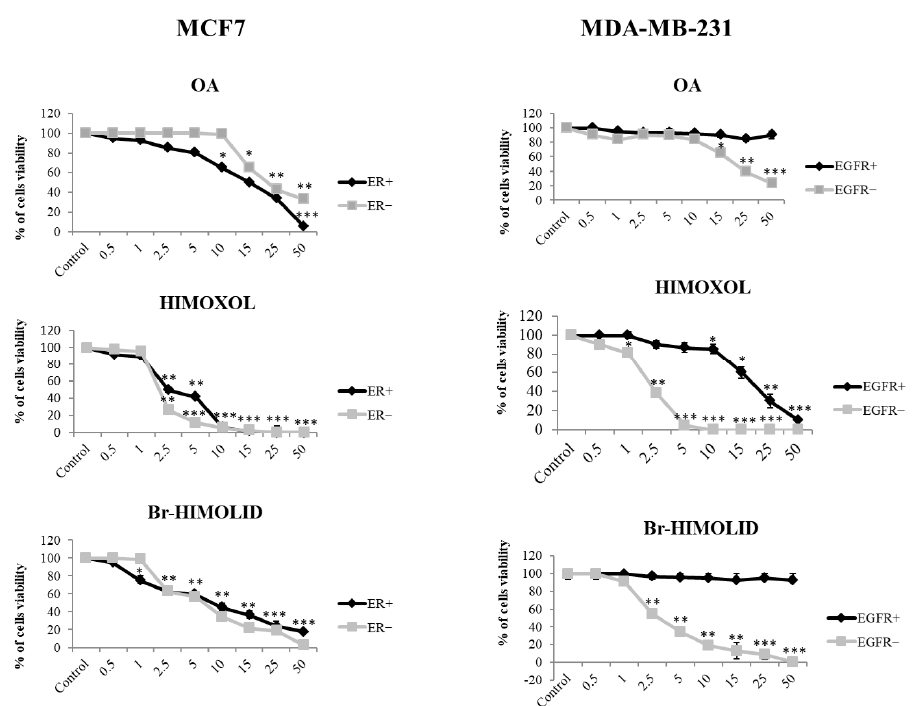
Figure 2. Viability of MCF7 and MDA-MB-231 cells with and without blocking the ER- or EGFR- mediated pathways. Cells were treated with OA, HIMOXOL, or Br-HIMOLID after blocking specific receptors (fulvestrant or gefitinib, respectively), in a concentration range of the compounds 0.5–50 µM for 24 h. Experiments were performed in duplicates. The data from the viability of MCF7/ER+ and MDA-MB-231/EGFR+ cells were published earlier [25,26]. * p < 0.05, ** p < 0.005, *** p < 0.001, relative to control.